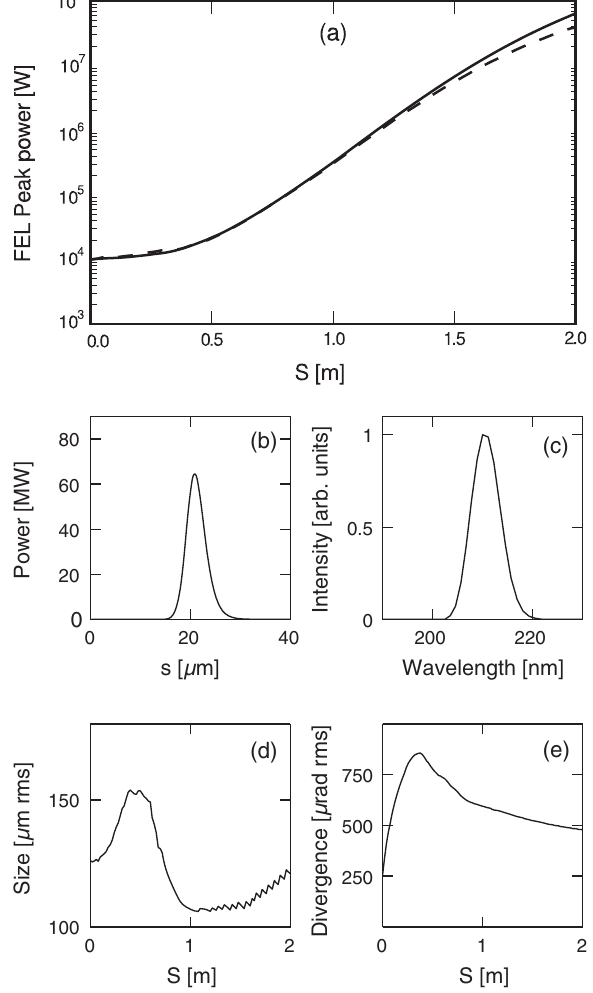
FIG. 5. (a) FEL power along the undulator simulated with (line) BETA, sympletic 6D tracking and GENESIS, (dashed line) OCELOT and CHIMERA. (b) FEL peak power longitudinal profile, (c) FEL spectrum at the undulator exit, (d) FEL radiation size and (e) FEL divergence along the undulator, simulated with GENESIS. (a – e) Beam transport simulation in the nonlinear case without collective effects and using the S2I-CM optics